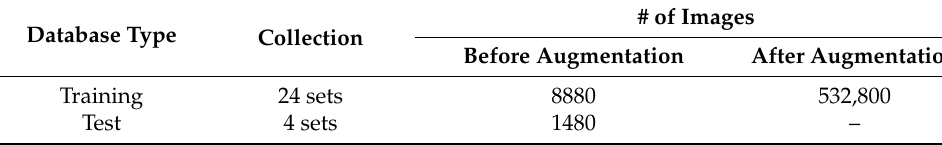
Table 1. Database information and augmentation size.